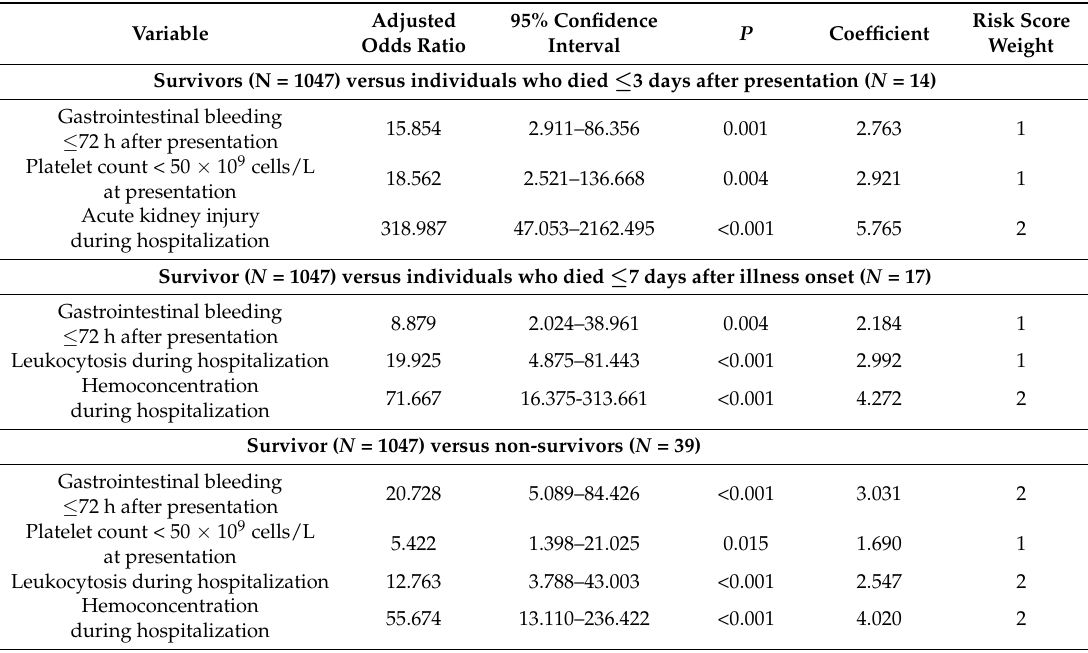
Table 3. Multivariate logistic regression model for survivors versus